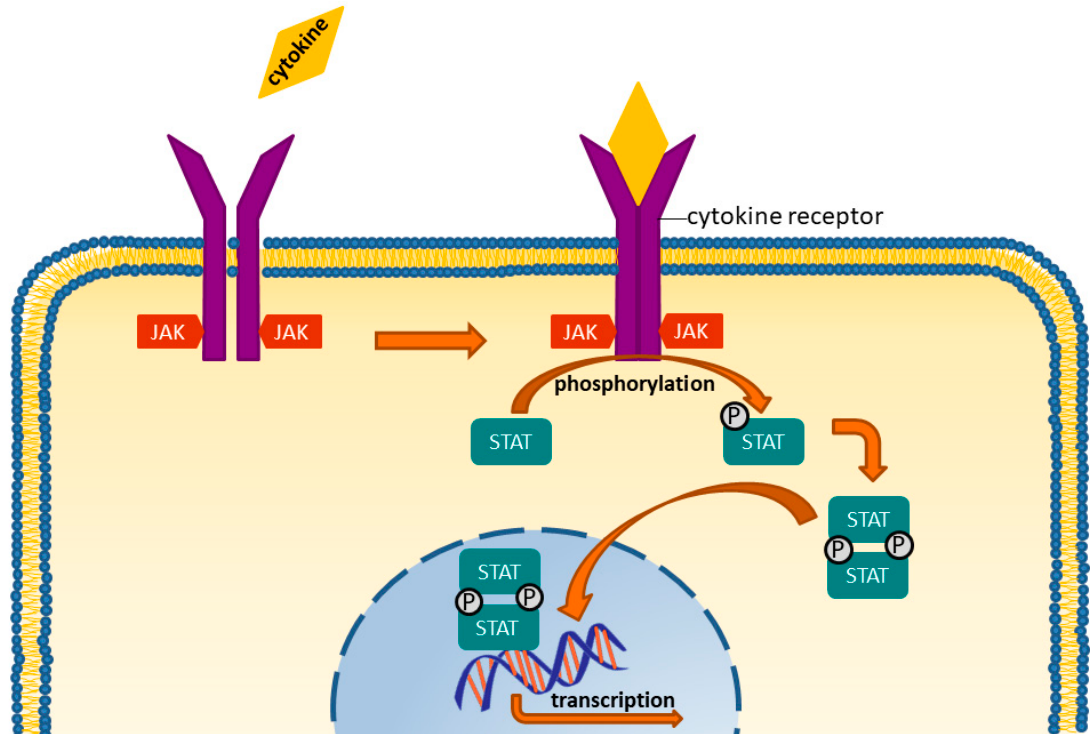
Figure 2. Cytokines bind to the receptors, which then undergo a change in their configuration into a dimeric structure, thereby activating their ability to work as a kinase. Consequently, they phosphorylate the STAT molecules (Signal Transducer and Activator of Transcription). Phosphorylated STATs also form dimeres that travel to the cell core, where they activate transcription processes, which further fuel inflammatory processes.